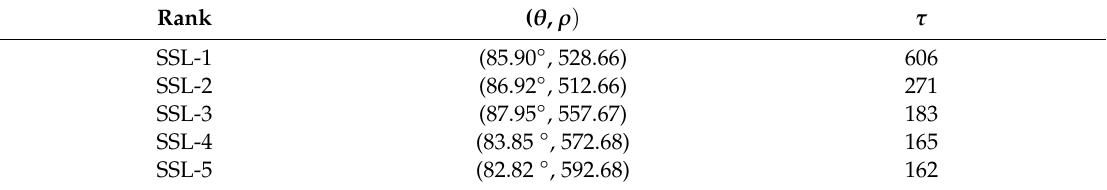
Figure 8. Hough space of the edge detection image. Table 1. Hough spatial parameters of candidate SSLs ranked top five.